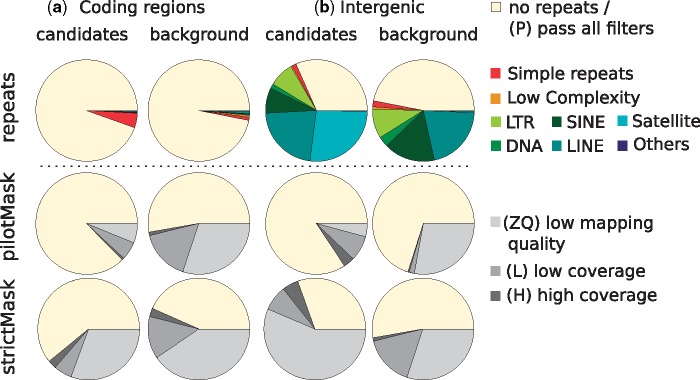
—Overlap of error candidates (left) and background variants (right) with repeated regions (top) in the genome and accessibility filters provided by the 1000 Genomes Projects (middle and bottom). Candidates and 20,000 background variants detected using the minor allele frequency filter ≥5% were overlapped with known repeats in RepeatMasker (http://www.repeatmasker.org; last accessed September 1, 2017) annotation for hg19 downloaded from UCSC genome browser, and two filters from the 1000 Genomes Project considering coverage and mapping quality. The coverage filters exclude regions where the depth of coverage (summed across all samples) was higher or lower than the average depth by a factor of 2-fold (pilotMask) or by 50% (strictMask). Regions are deemed as lowly mappable if >20% of overlapping reads have mapping quality of zero (pilotMask) or >0.1% (strictMask). LTR, RNA related repeats, and repeats classified as “unknown” or “others” by RepeatMasker are here labeled as Others, in dark blue.